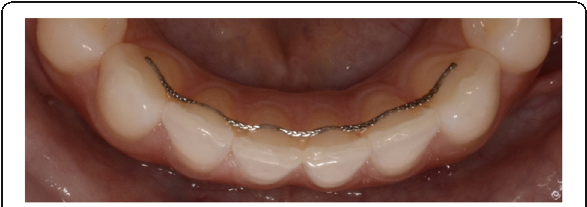
Fig. 2 .016 ″ × .022 ″ eight-strand braided SS wire (D-Rect., ORMCO) bonded to all 6 lower anterior teeth at T 3